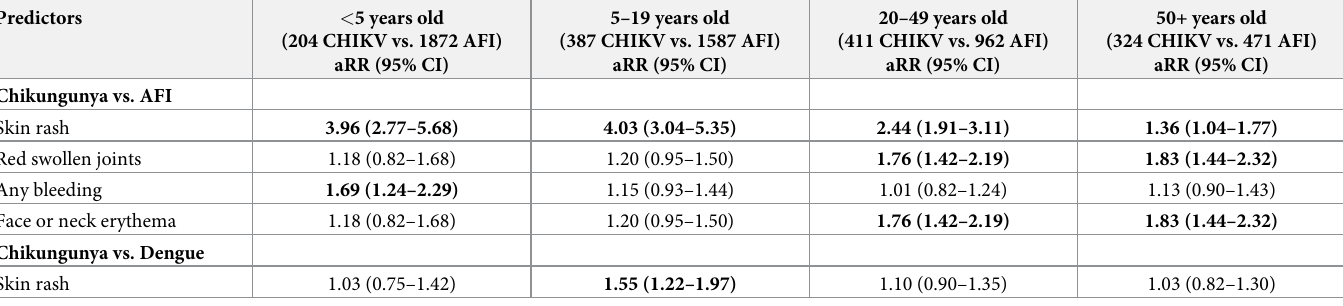
Of the 8,996 participants enrolled in our AFI study, nearly one-fifth had chikungunya. Chi- kungunya cases were more likely than other AFI cases to be older and a higher proportion reported having at least one chronic medical condition. This pattern of disease has been seen in other areas with recent CHIKV emergence [43, 44] and may be due to differences in health- seeking behaviors and/or complications among older individuals with preexisting co- Table 5. Age group-specific early predictors of laboratory-confirmed chikungunya versus all other acute febrile illnesses or laboratory-confirmed dengue, Acute Febrile Illness Study, May 7, 2012–May 6, 2015, Puerto Rico. Predictors < 5 years old (204 CHIKV vs. 1872